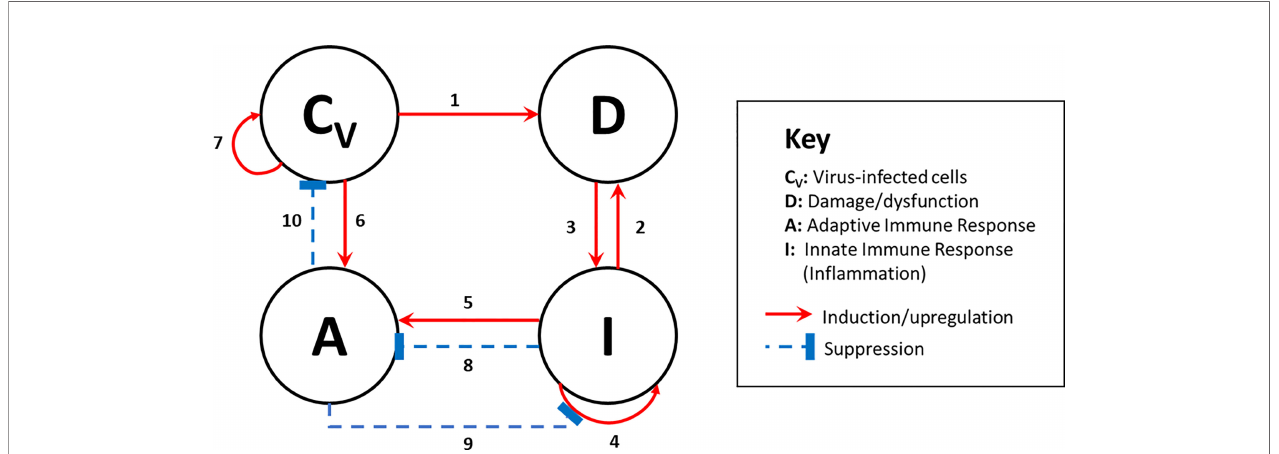
FIGURE 1 | Model Interaction Diagram. Beginning at the top left of the diagram and explaining in a clockwise direction: The presence of virus-infected cells, C V , initiates the induction of damaged or dysfunctional tissue (arrow 1), modeled with the variable D . The lysis of virus-infected cells will lead to subsequent infection of other cells (arrow 7). The release of DAMPs from virus-infected cells occurs prior to the release of type I interferons due to virus-mediated inhibition of type 1 interferon production. Thus, DAMPs predominate in initiating innate immune activation and systemic in fl ammation (arrow 3), represented with variable I , that will self- upregulate (arrow 4). The effects of in fl ammation can create collateral host tissue damage (arrow 2), providing positive feedback into D . The priming of an adaptive response, A , is initiated and upregulated by I (arrow 5), and A in turn inhibits the upregulation of I (arrow 9). If the I response becomes strong enough, I switches to inhibiting the upregulation of A (arrow 8). The adaptive response, A , will also be stimulated in response to PAMP signaling from virus-infected cells, albeit with somewhat delayed kinetics because of viral proteins that attenuate such signaling mechanisms (arrow 6). When encountering virus-infected cells, A can kill these cells ( C V ) by the action of virus-speci fi c cytotoxic T cells and/or neutralize the virus with antibody secreting virus-speci fi c B cells, thereby inhibiting the expansion of the virus-infected cell population (arrow